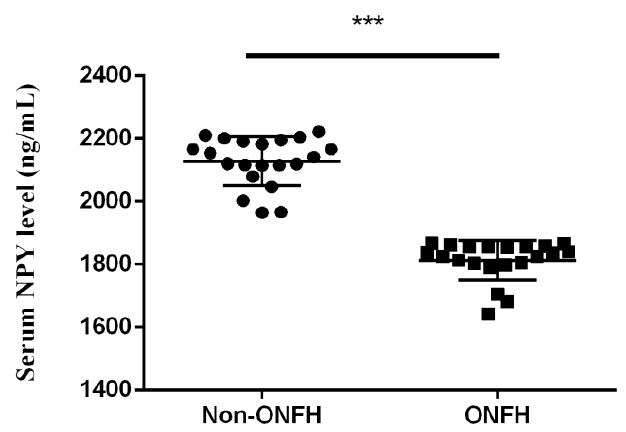
Figure 2. The serum NPY levels among non-ONFH and ONFH patients (*** p < 0.001). The primary BMSCs harvested from ONFH femoral heads were treated with Y1R agonist (Leu 31, Pro 34) and Y1R antagonist BIBO3304 of graded concentrations. The sta- tus of cellular apoptosis was evaluated by TUNEL-DAPI staining. TUNEL-DAPI staining (Figure 3) showed that the Y1R agonist (Leu 31, Pro 34) lead to the apoptosis of BMSCs.